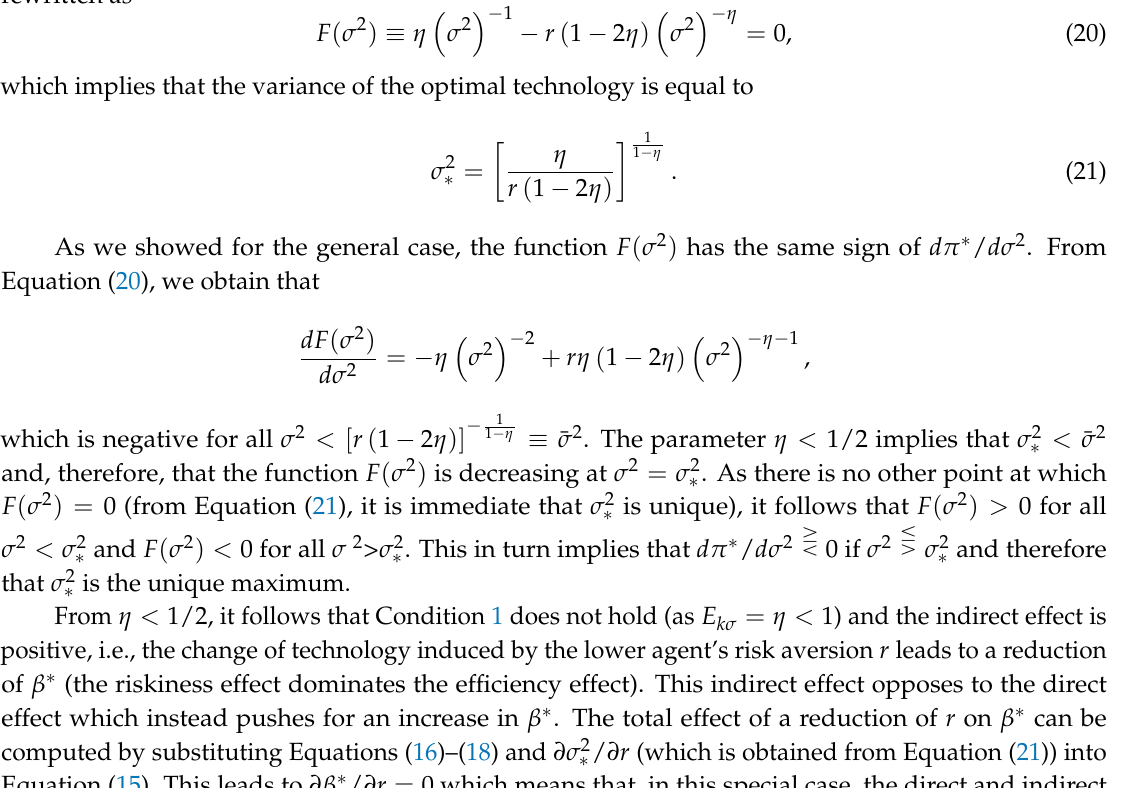
Table 95: txfonts / pxfonts Inequalities 4